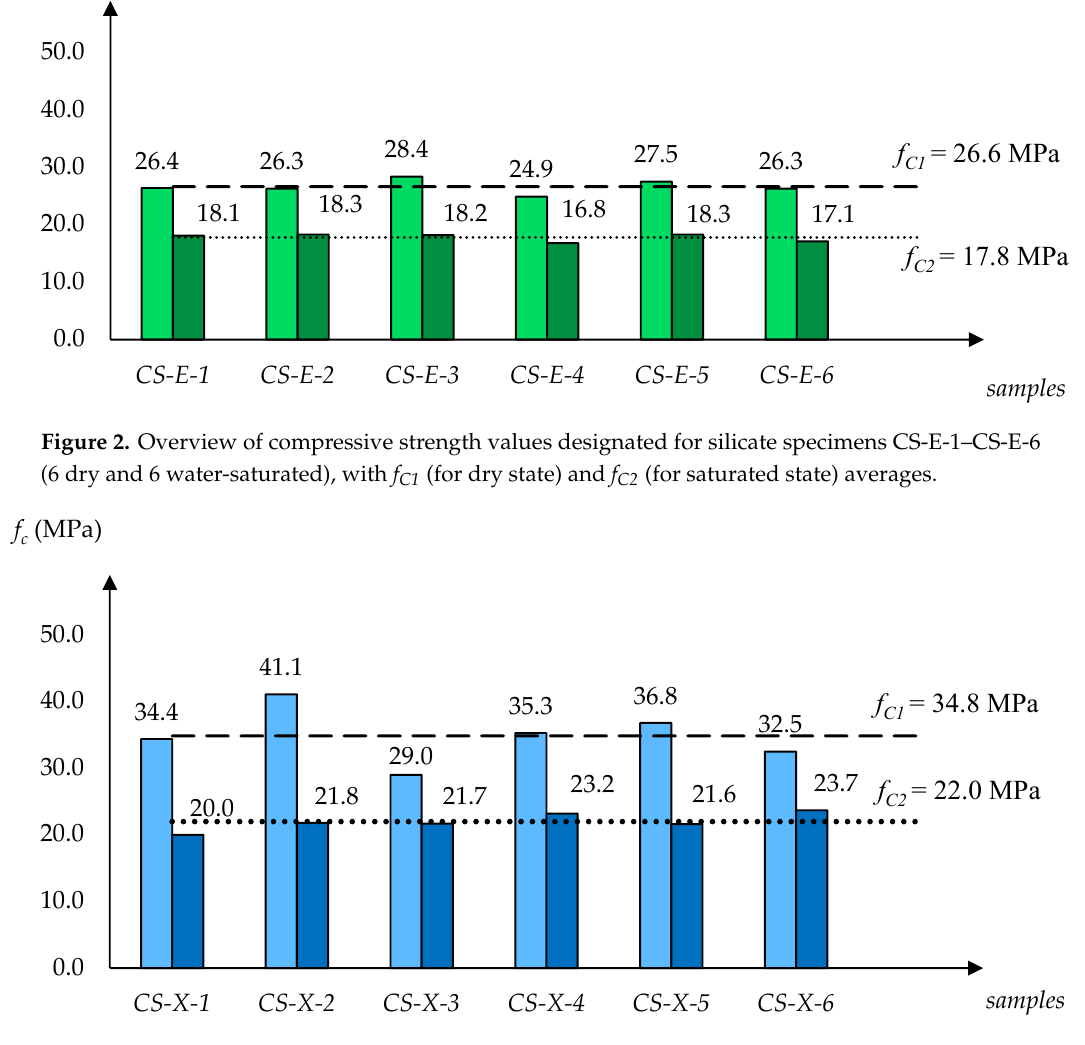
Figure 3. Overview of compressive strength values designated for silicate specimens CS-X-1–CS-X-6 (6 dry and 6 water-saturated), with f C1 (for dry state) and f C2 (for saturated state) averages.